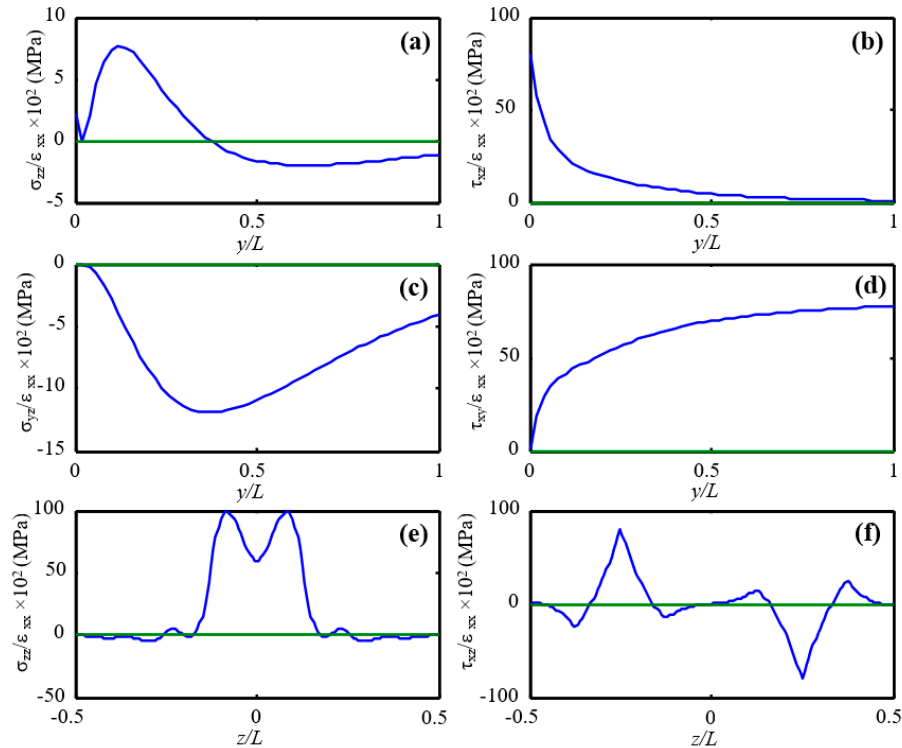
Figure 9. Predicted free-edge stresses based on stress-function variational method ( L : laminate thickness, 1.35 mm; ε xx = 0.01 in simulation; laminate ( x, y, z )-coordinate system according to Figure A1). ( a ) Normal stress σ zz along 45 ◦ / − 45 ◦ interface within L -distance free edge (left); ( b ) out-of-plane shear stress τ xz along 45 ◦ / − 45 ◦ interface within L -distance free edge (left); ( c ) in-plane shear stress τ yz along 45 ◦ / − 45 ◦ interface within L -distance free edge (left); ( d ) in-plane shear stress τ xy along 45 ◦ / − 45 ◦ interface within L -distance free edge (left); ( e ) normal stress σ zz across laminate thickness at the left free edge; ( f ) out-of-plane shear stress τ xz across laminate thickness at the free edge.